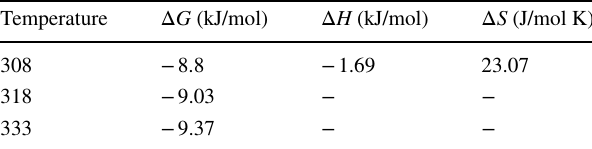
Table 6 Thermodynamic parameters for the adsorption of MG